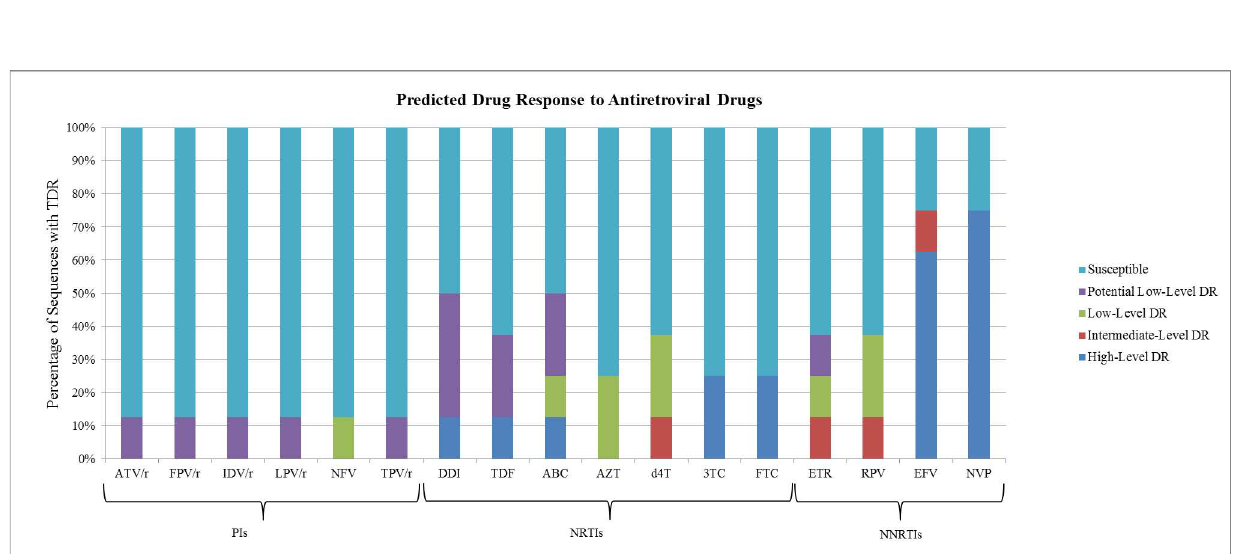
Fig 1. Predicted antiretroviral (ARV) drug responses of eight persons with TDR mutations. Drug responses were basedon the Stanford HIVdb v7.0 report. The y-axis indicatesthe percentage number of sequenceswith TDR whilethe x-axis indicatesthe different ARV drug classes that were affected by the TDR mutations. Drugs that were unaffectedby any particularTDR were excludedfrom the analyses. TDR— Transmitted Drug Resistance; PIs—Protease Inhibitors; NRTIs—NucleosideReverse Transcriptase Inhibitors;